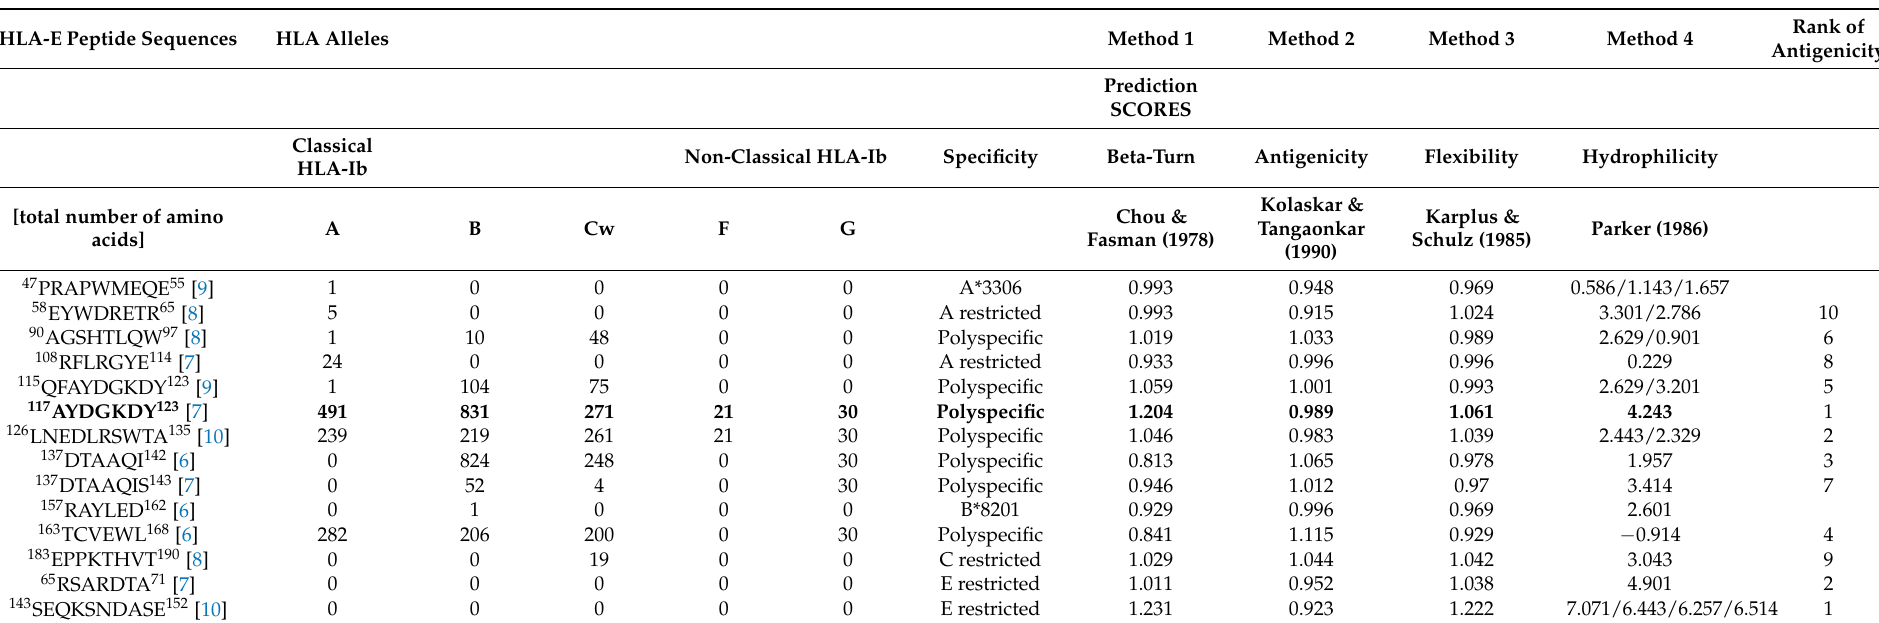
Table 2. Comparison of the amino acid sequence of HLA-E with sequences of five other HLA isoforms. Several peptide sequences of HLA-E are shared with the alleles of other HLA-I isoforms. Note that amino acid sequence AYDGKDY is shared with the maximum number of alleles of all isoforms of HLA-I, while sequences PRAPWMEQE and EPPKTHVT are shared with one allele of HLA-A (A*3306) and one allele of HLA-B (B*8201). The bioinformatics analysis was carried out using the Immune Epitope Database (IEDB) to predict the antigenicity rank of epitopes. The Chou and Fasman beta turn, Kolaskar and Tongaonkar antigenicity, Karplus and Schulz flexibility, and Parker hydrophilicity prediction methods in IEDB were employed. The methods predict the probability of specific sequences in HLA-E that bind to Abs being in a beta turn region, being antigenic, being flexible, or being in a hydrophilic region. Antigenicity rank is calculated by pooling the probability